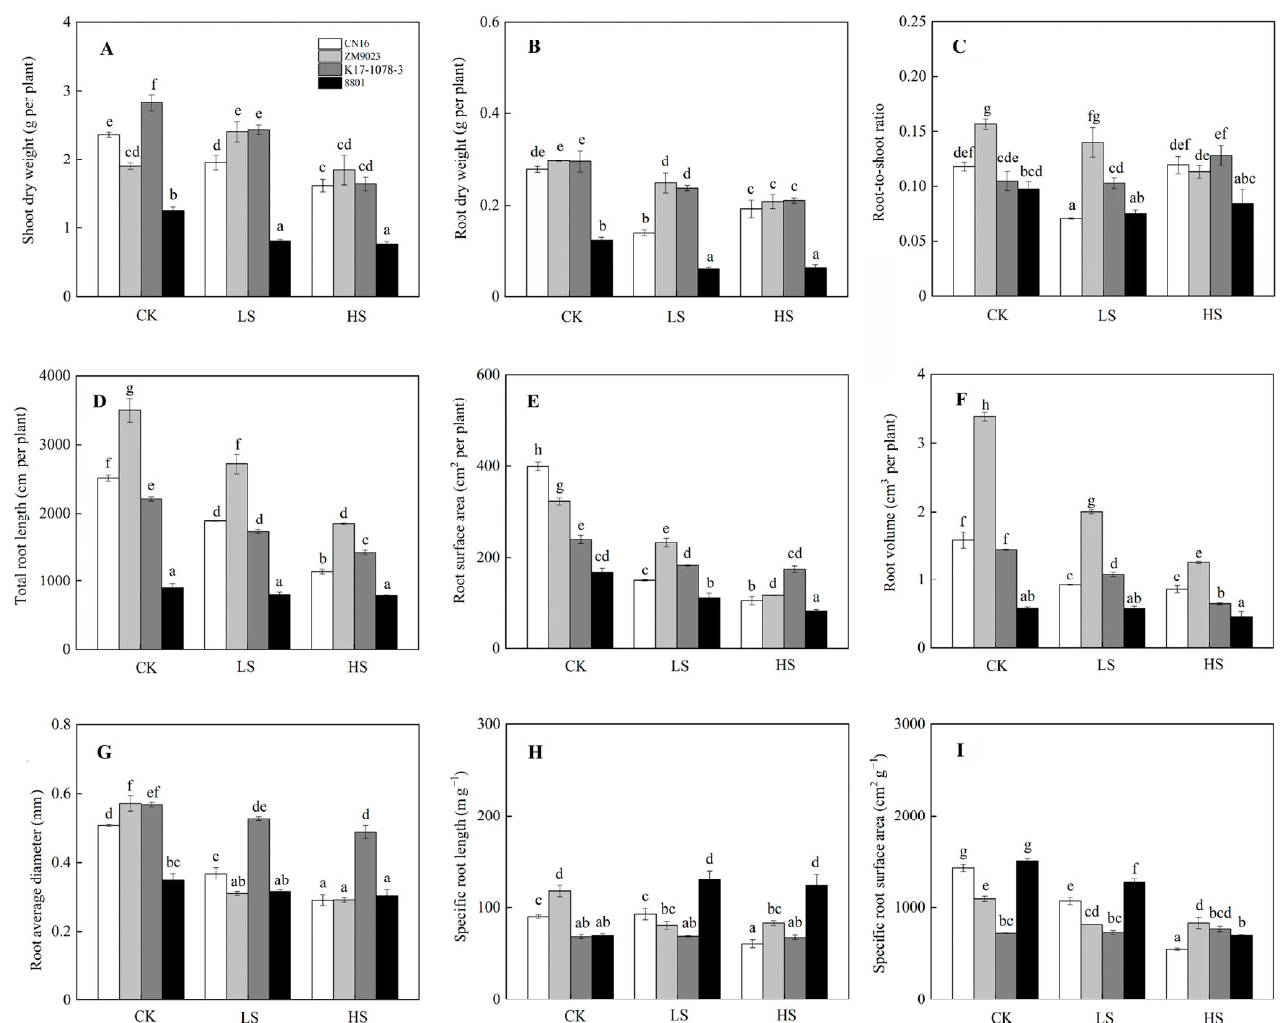
Figure 2. Shoot dry weight ( A ); root dry weight ( B ); root-to-shoot ratio ( C ); total root length ( D ); root surface area ( E ); root volume ( F ); root average diameter ( G ); specific root length ( H ) and specific root surface area ( I ) variations in K17-1078-3 and its parents subjected to different salinity levels. Different letters indicated significant difference due to salt treatments according to Duncan’s multiple range tests. CK, LS, and HS referred to NaCl concentrations of 0, 50, and 200 mM. Salt exposure inhibited photosynthetic ability in four wheat genotypes with K17-1078- 3 and 8801 showing higher P n and g s , but lower T r than CN16 and ZM9023 under LS and HS treatments (Figure 3). K17-1078-3 and 8801 had higher WUE than CN16 and ZM9023 under all treatments. K17-1078-3 and 8801 had lower Ls than CN16 and ZM9023 under LS and HS treatments (Figure 3). Salt stress changed the characteristics of chlorophyll fluorescence, especially under HS treatment. HS treatment significantly reduced F v /F m , qP, yield and ETR, and the decreases of CN16 and ZM9023 were greater than those of K17-1078-3 and 8801. K17-1078-3 had significantly higher NPQ than the other three wheat genotypes under HS treatment (Figure